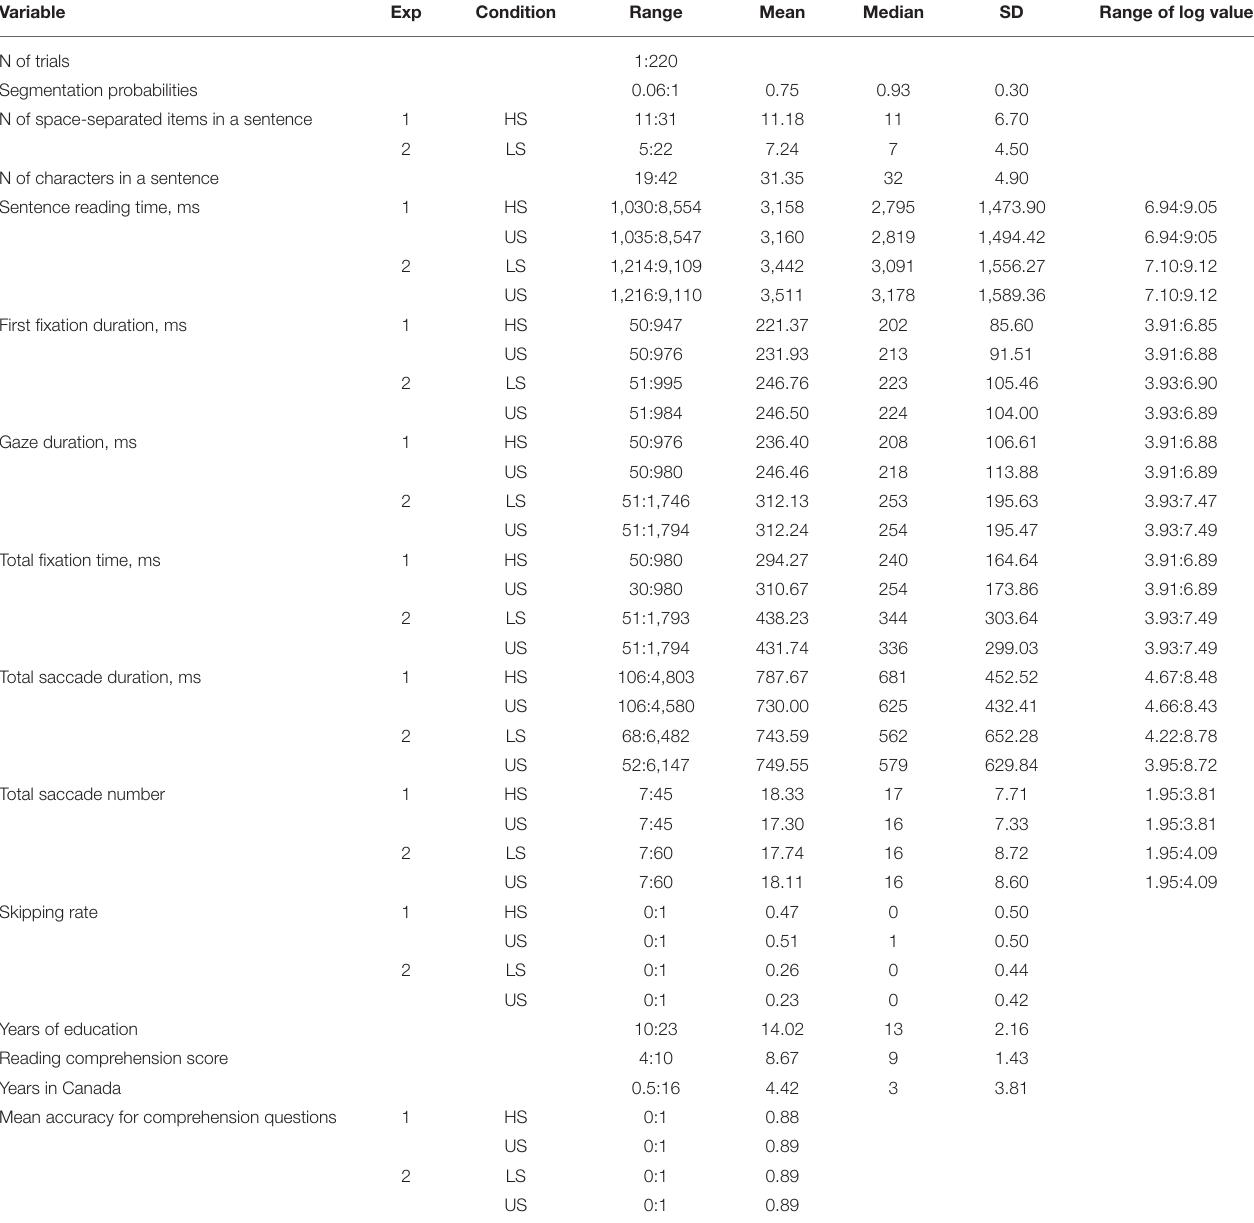
TABLE 2 | Descriptive statistics of independent and dependent variables across three conditions. Variable Exp Condition Range Mean Median SD Range of log values